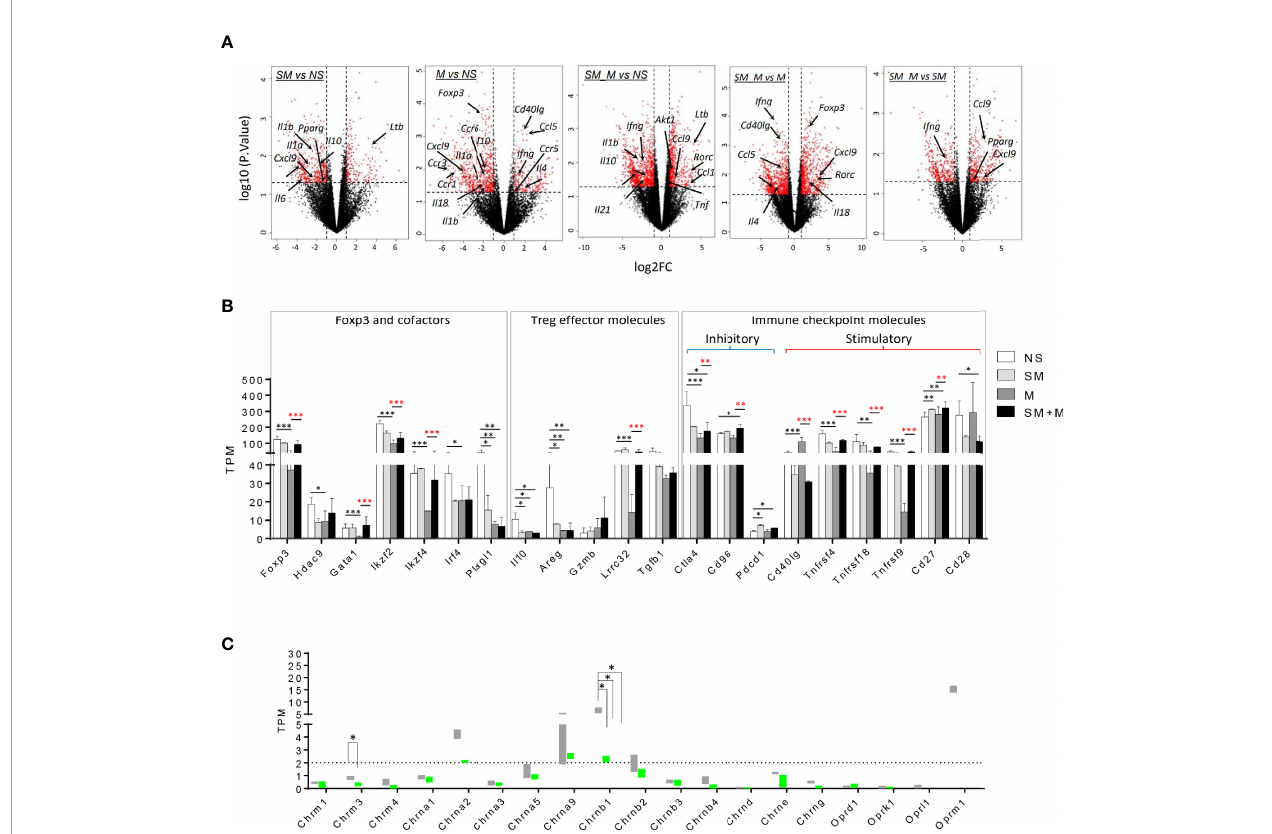
FIGURE 2 | Morphine (M) is stronger than cigarette smoke (SM) in re-shaping Treg cell transcriptomes and SM + M have synergy in modulating Treg cell transcriptomes. (A) Volcano plots illustrate log 10 (p-value) in relation to the log 2 (fold change) for the treatments versus control (n = 2). The differentially expressed genes with -log10 (p. value) >1.3 and |log2FC| >1 are displayed in red. Cytokines, chemokines and receptors with transcriptomic changes are labeled. (B) Bar graph show the level of transcripts of Foxp3 and cofactors, Treg effector molecules, and immune checkpoint molecules in Treg from four groups. (C) Bar graph show the level of transcripts of 15 nicotinic receptors and 4 opioid receptors in Treg from four groups. TPM, Transcripts per Million mapped reads (T test, *p < 0.05, **p < 0.01, ***p < 0.001, * in black represents the difference between SM, M or SM+M and NS control, * in red represents the difference between SM+M and SM or